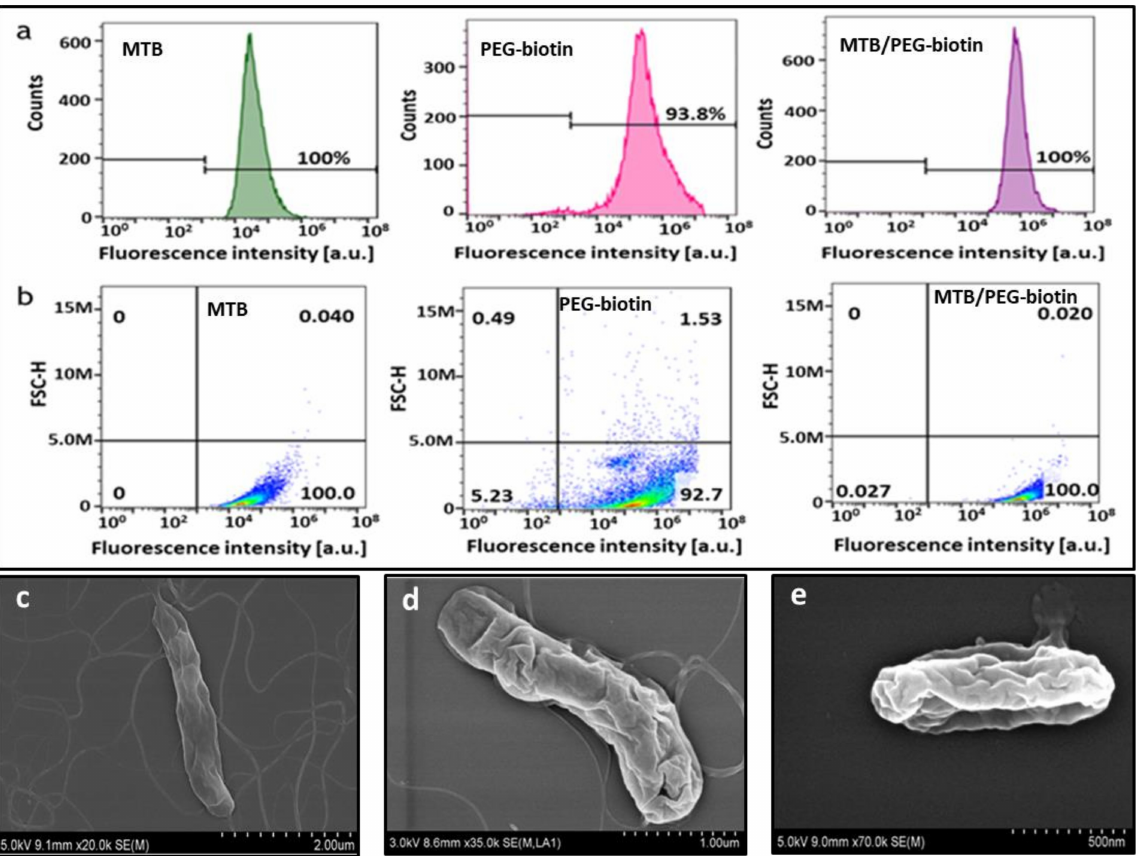
Figure 3. Characterization of the MTB/PEG–biotin complex. ( a ) FACS histograms and ( b ) density plots obtained from bare MTB, FITC-labeled PEG-biotin, and the MTB/PEG-biotin complex show that PEG–biotin is uniformly attached to MTB, and can be distinguished from bare MTB by fluorescence intensity. ( c ) FE-SEM images of bare MTB. MTB/PEG–biotin complex formation when the PEG–biotin concentration used was ( d ) 10 mM and ( e ) 20